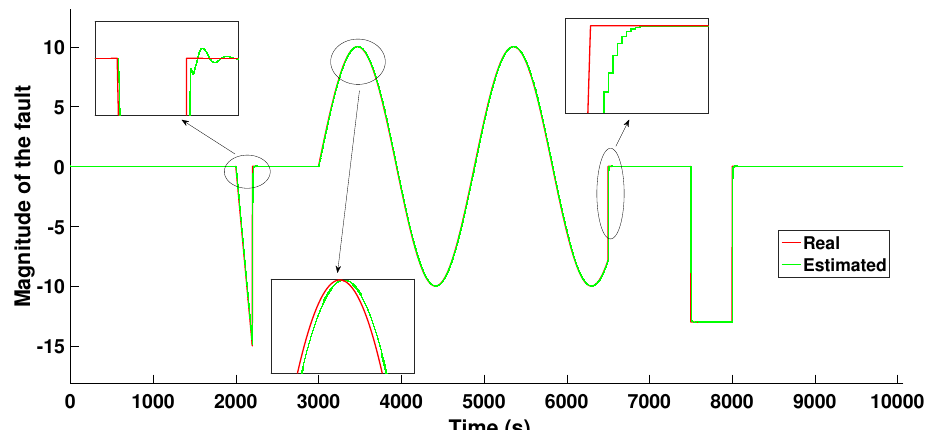
Figure 25. Scenario 2 − Multiple faults: Real and estimated faults injected on the PSA virtual plant. A comparison between the control signals generated by the active FTC and the discrete PID controller is presented in Figure 26. The signals generated by the discrete PID are smooth but with an oscillating tendency when the sine wave-type fault is injected. Likewise, a greater control effort is observed when the step-type fault occurs, generating temperatures between 310 K and 275 K. The active FTC has less effort on sine wave and step faults, quickly exceeding the effort generated to maintain the PSA process stable and reduce the fault effect.